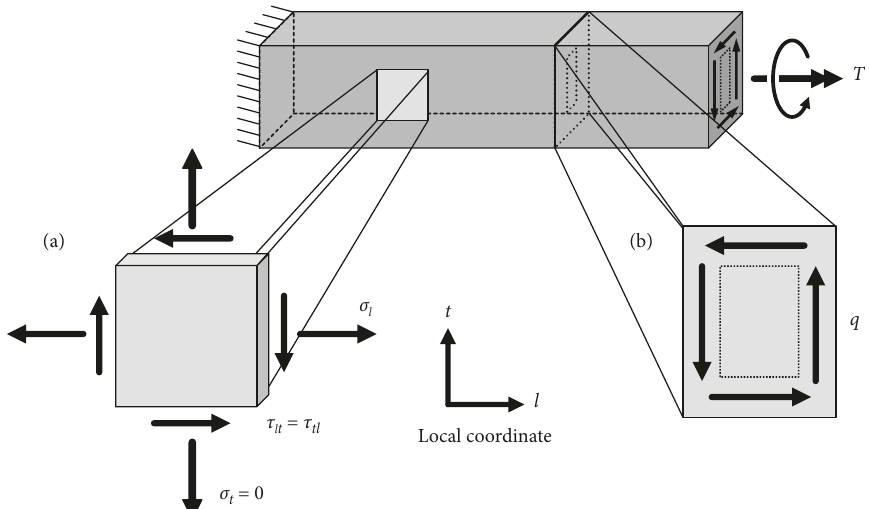
Local coordinate